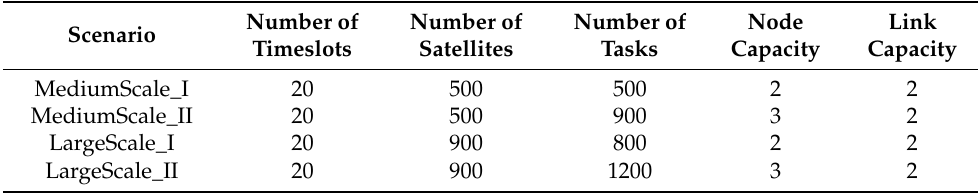
Table 12. Real scenario parameters.